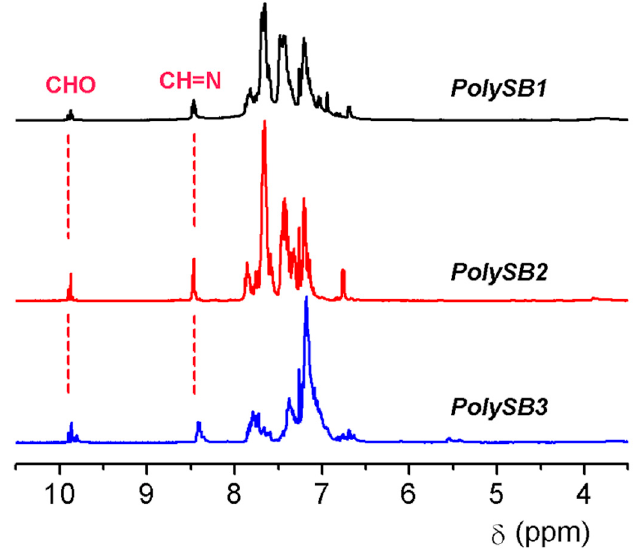
Figure 3. Aromatic region of the 1 H NMR spectra (CDCl 3 , 400 MHz) of polySBs.